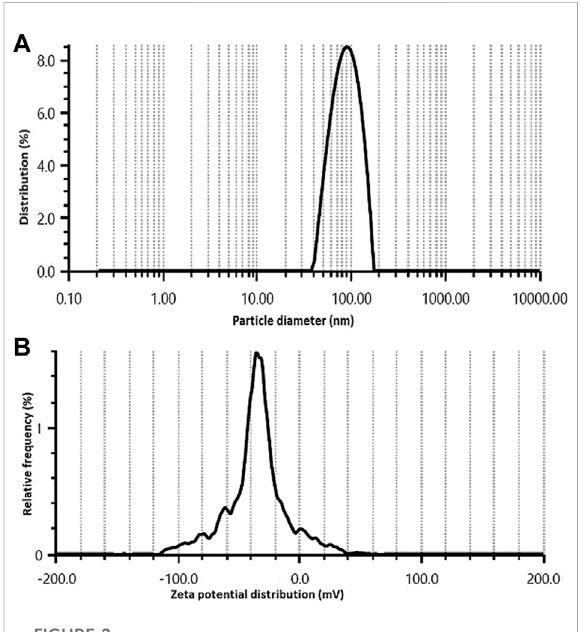
FIGURE 2 Size distribution (A) and zeta potential (B) of Rn-AgNPs obtained using aqueous extracts of R. nepalensis .